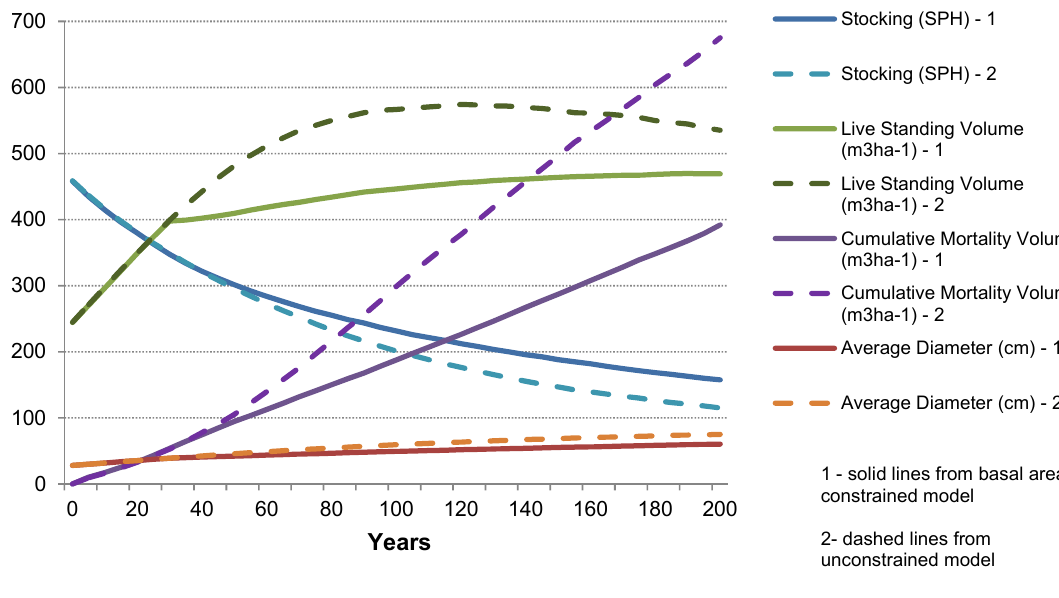
Figure 4. North Coast Blackbutt study areas—“ conservation ” scenario modelled stand parameters under BA constrained and unconstrained DBH increment models.